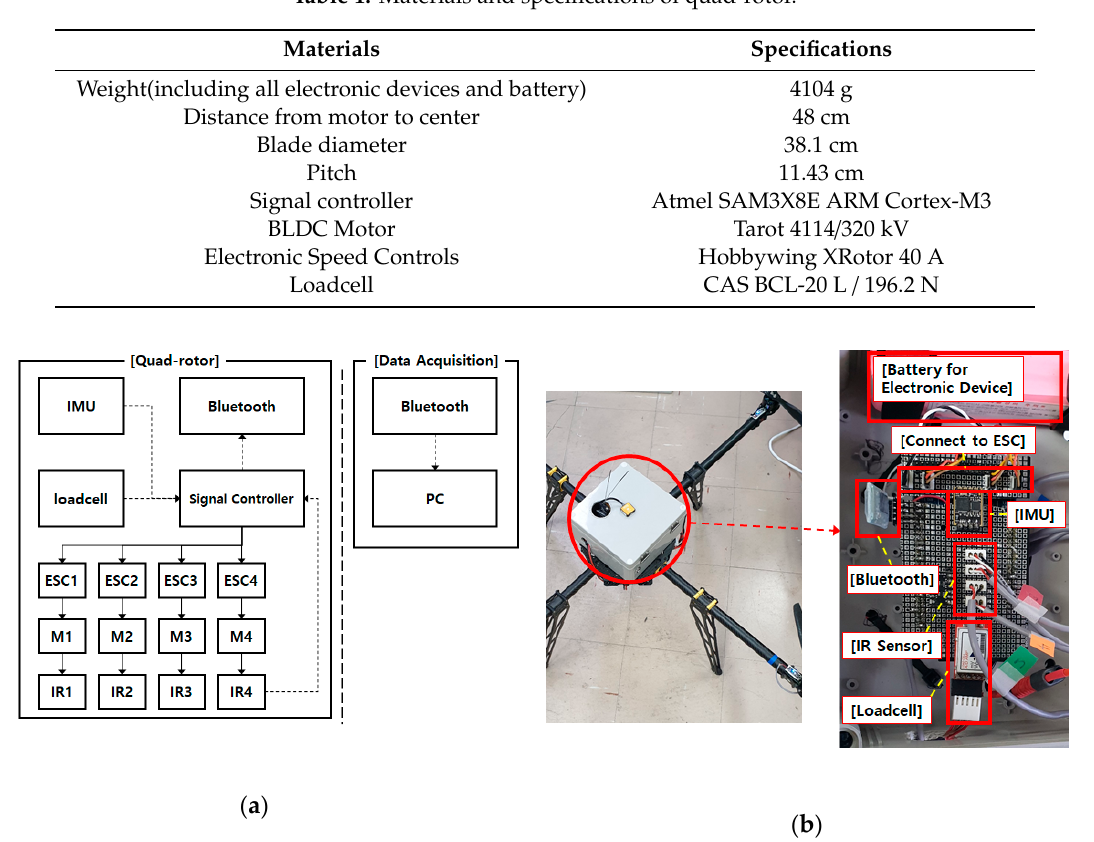
Table 1. Materials and specifications of quad-rotor.